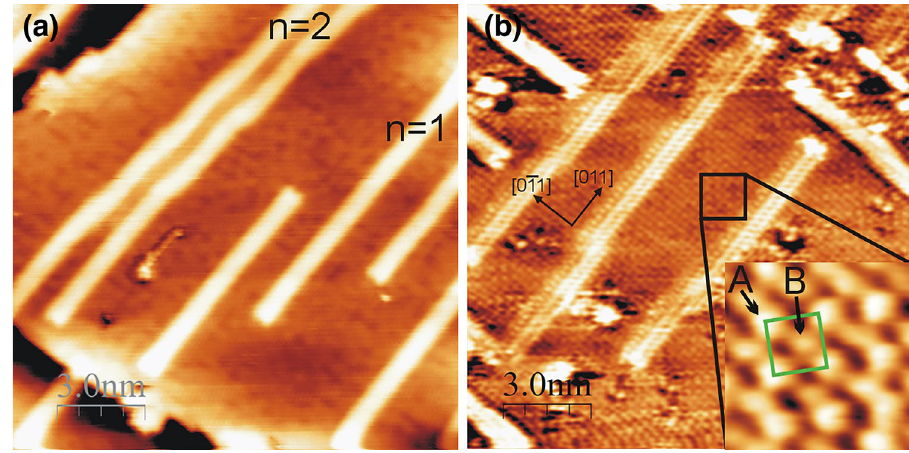
Figure 2. STM images of Pt/Au(100) obtained after annealing of (a) 0.3 ML at 100 °C; (b) 0.4 ML at 100 ÷ 200 °C. Taken for (a) U = − 1489 mV; I = 8.1 nA; (b) U = + 215 mV; I = 8.7 nA; insert: U = −132 mV; I = 8.9 nA.